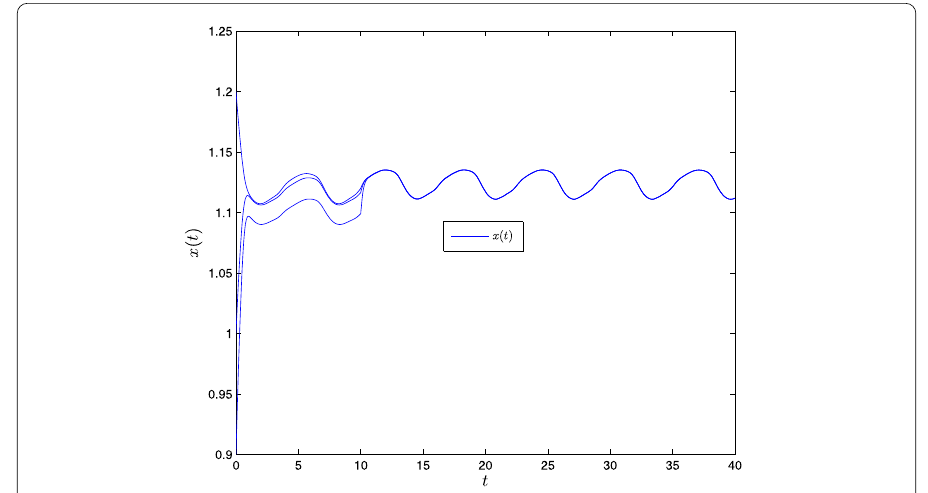
Figure 1 Numerical solutions on the state trajectories of state variables x of system (4.1) for differential initial values: ϕ ( s ) = 0.9,1,1.2, s ∈